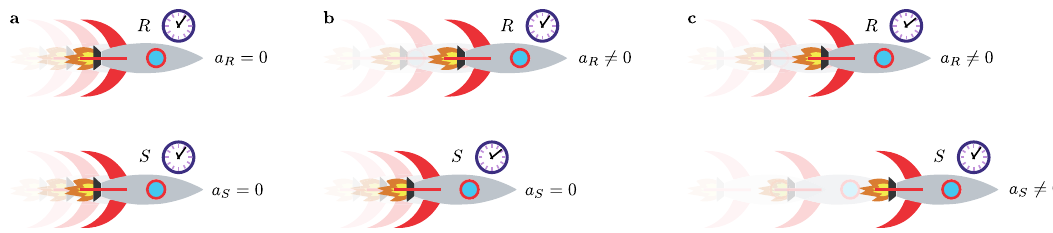
Fig. 1 Representation of non-interacting travelling rocket ships. Ships R and S have each their own internal quantum time. If both rockets are at rest or moving with constant speed ( a R = a S = 0), as shown in a , the time evolution of systems described by either of them is unitary. However, if rocket R starts accelerating ( a R ≠ 0), as displayed in b , then the time evolution of systems from its clock ’ s perspective is, generally speaking, non-unitary, while the evolution from the perspective of rocket S ’ s clock remains unitary. Finally, none of the clocks gives a unitary evolution if both rockets are accelerating,